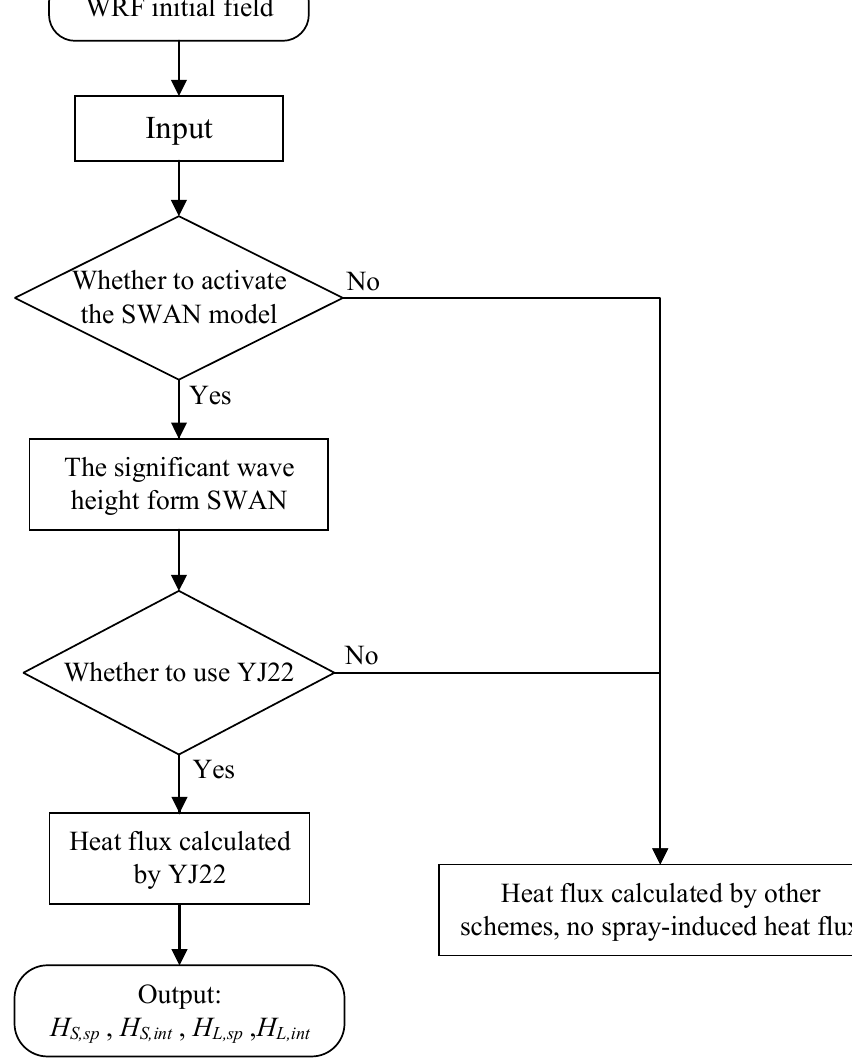
Figure 8. The flowchart of the YJ22 scheme is embedded in the COAWST model.